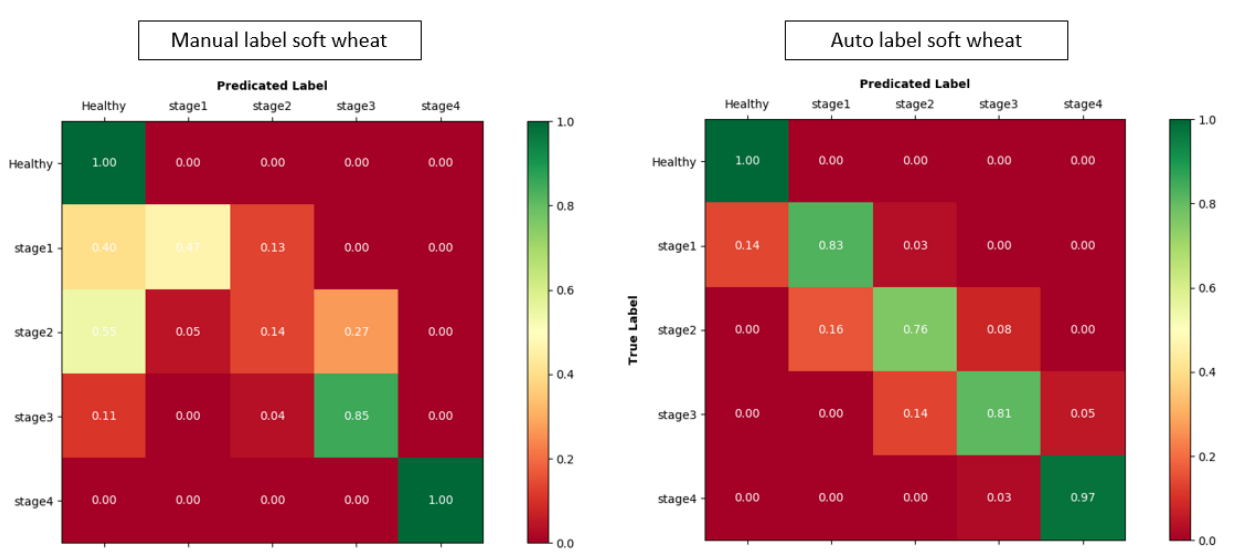
Figure 7. Comparison for durum wheat of the performances of the manually labelled model ( B ) with the automatically labelled model ( C ) with the red, green, and blue (RGB) representation of the hyperspectral image ( A ). Both the manually and automatically labelled datasets were fed into a logistic regression model, obtaining classification accuracies of 86.42% and 96.66% for the manual and automatic models, respectively. The color bar represents the label given by the automatic label- ling algorithm. 3.2. Potato For the potato dataset, the automatic labelling algorithm indicated two bands that showed labels matching the visible symptoms, namely, red edge band 2 and red edge band 3. Figure 8 shows the classification results of the manually labelled model and the automatically labelled model for potato. The manually labelled model achieved a classifi- cation accuracy of 79.45%, whereas the automatically labelled model achieved an accuracy of 98.80%. Not only was the classification accuracy of the manually labelled model lower than that of the automatically labelled model, but it also showed clear patterns where shading and angle effects affected the classification. These regions were even shown as a stage 3 disease in a few places.